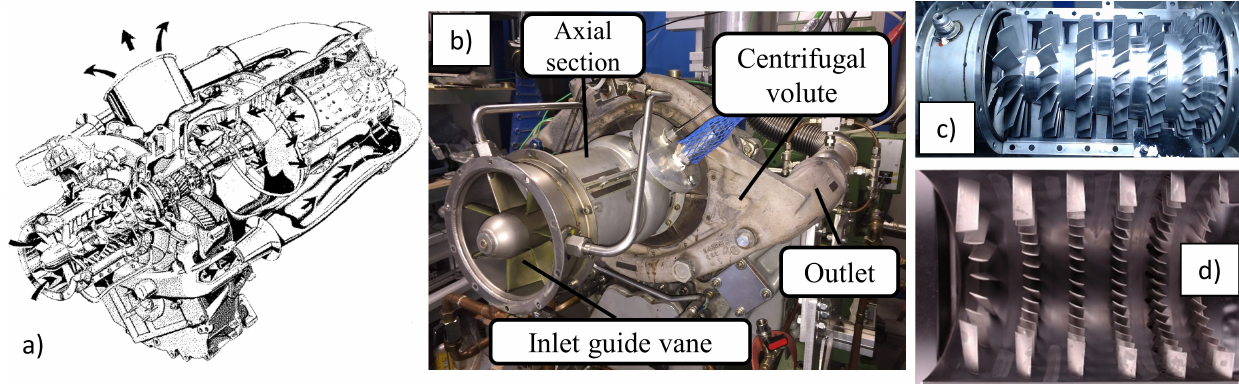
Figure 3. Allison 250 C18: ( a ) schematic view of the engine (taken from [22]); ( b ) side view of the compressor unit test bench; ( c ) rotor wheel; and ( d ) stator